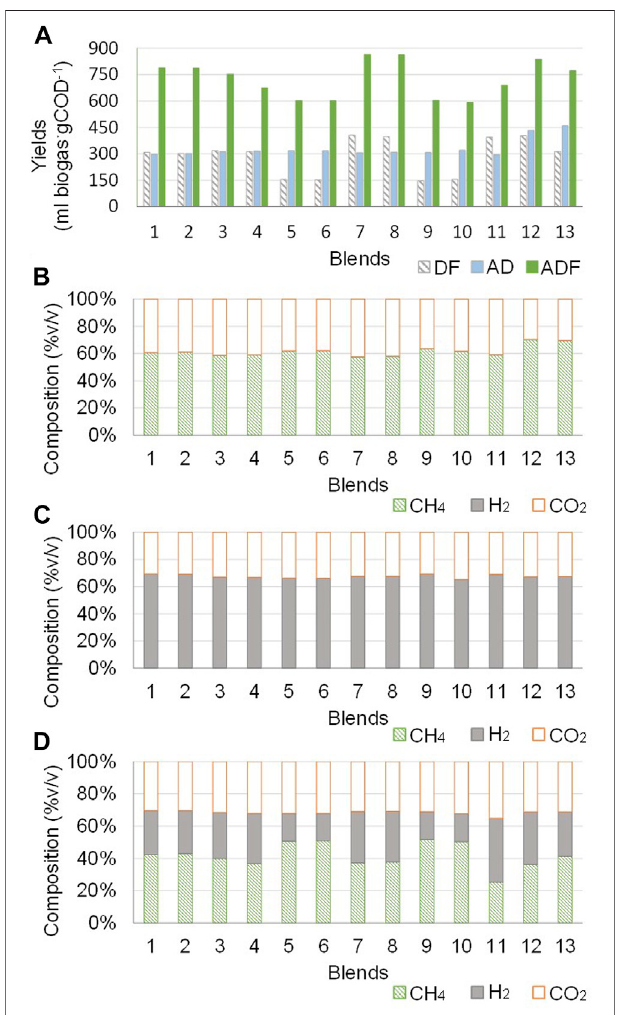
FIGURE 3 | Simulations of AD, DF, and ADF processes for the different substrate blends: (A) Total biogas production yields for AD, DF, and ADF; (B) Biogas composition for AD; (C) Biogas composition for DF; (D) Biogas composition for ADF.